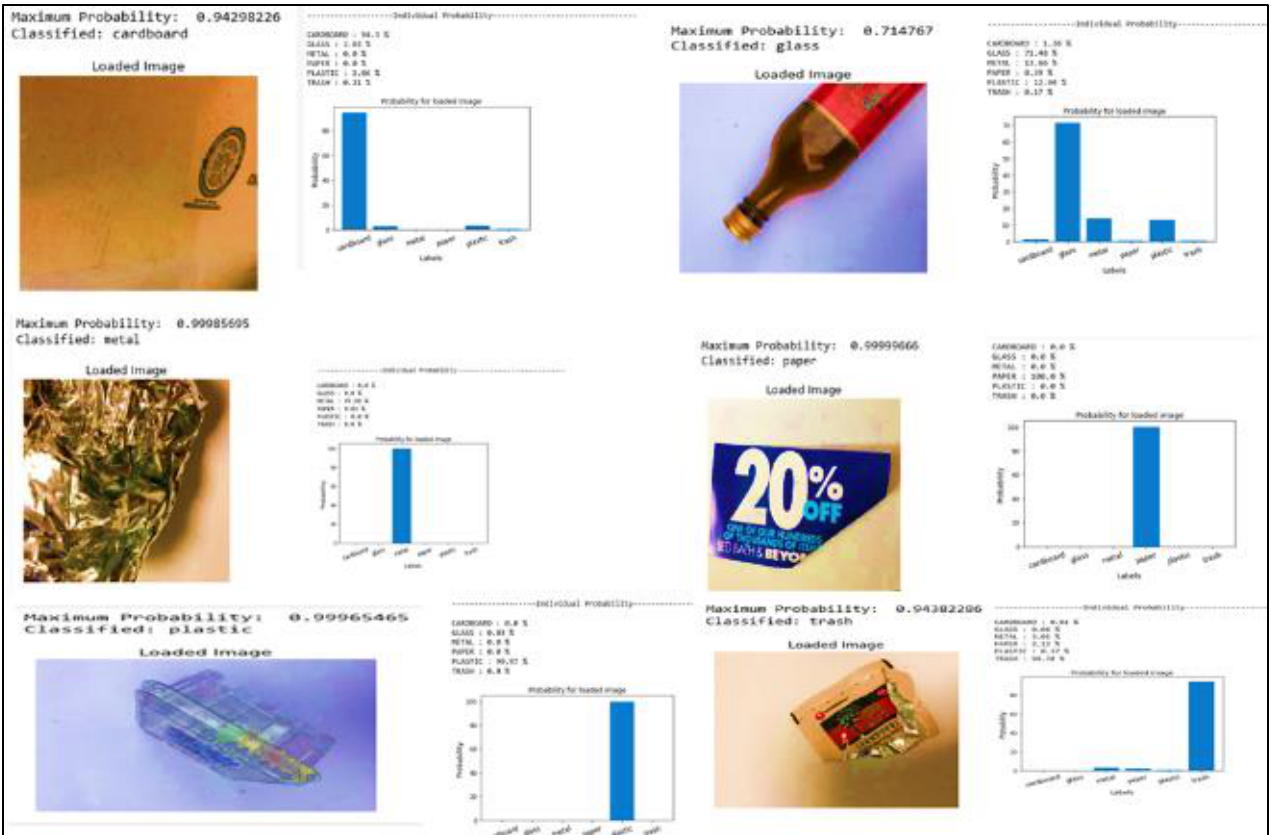
Figure 11. Classified Images and their Probability Graphs